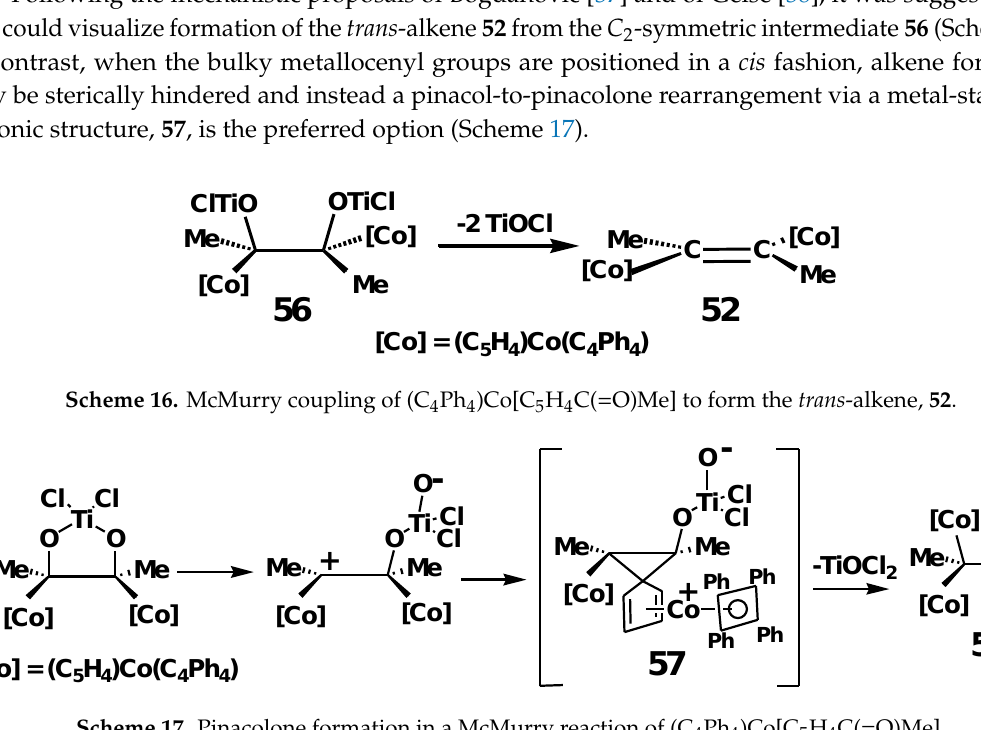
Figure 3. Transition states for ferrocenyl and phenyl rearrangements whereby positive charge is delocalized onto the migrating group.